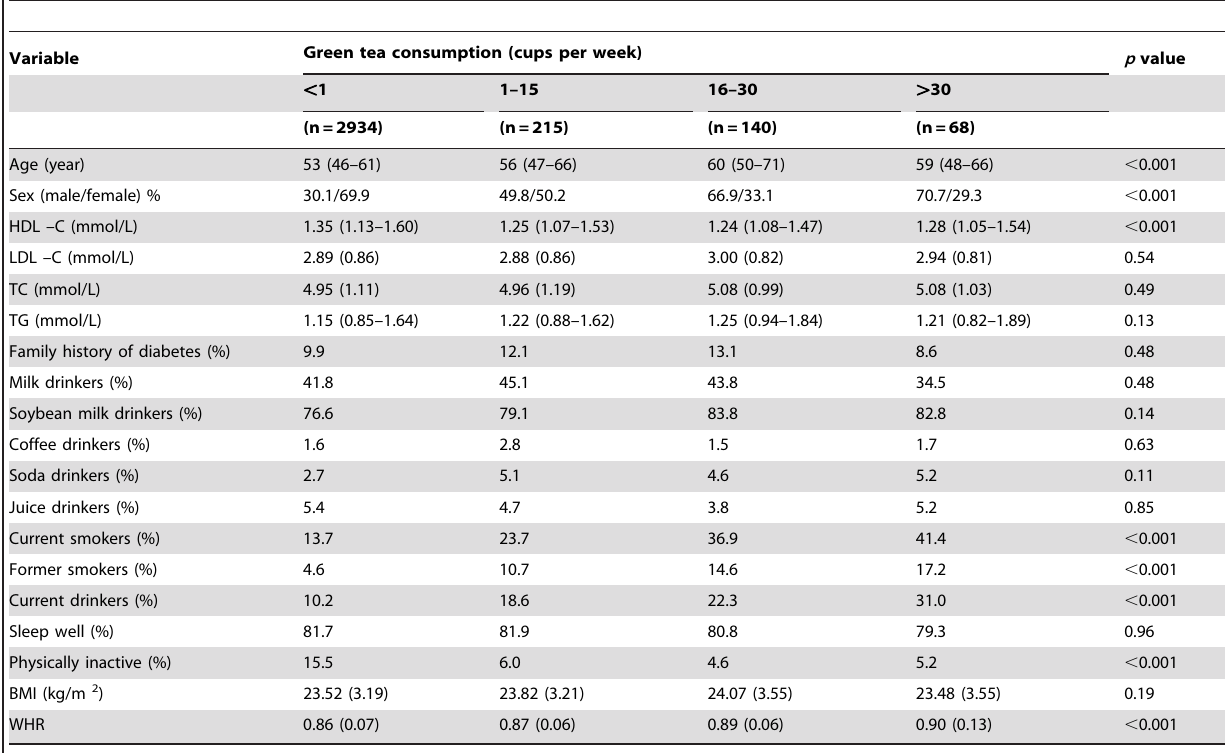
Table 1. Baseline characteristics grouped according to weekly consumption of green tea.